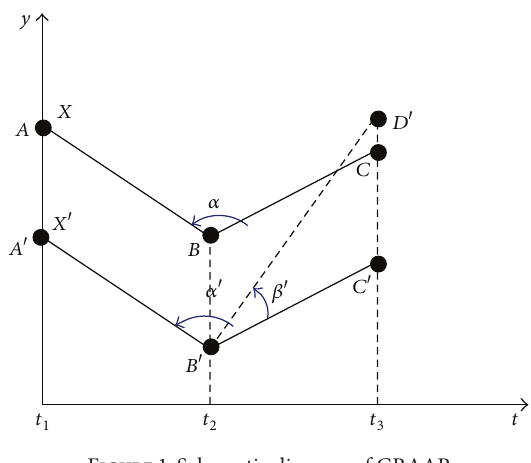
Figure 1: Schematic diagram of